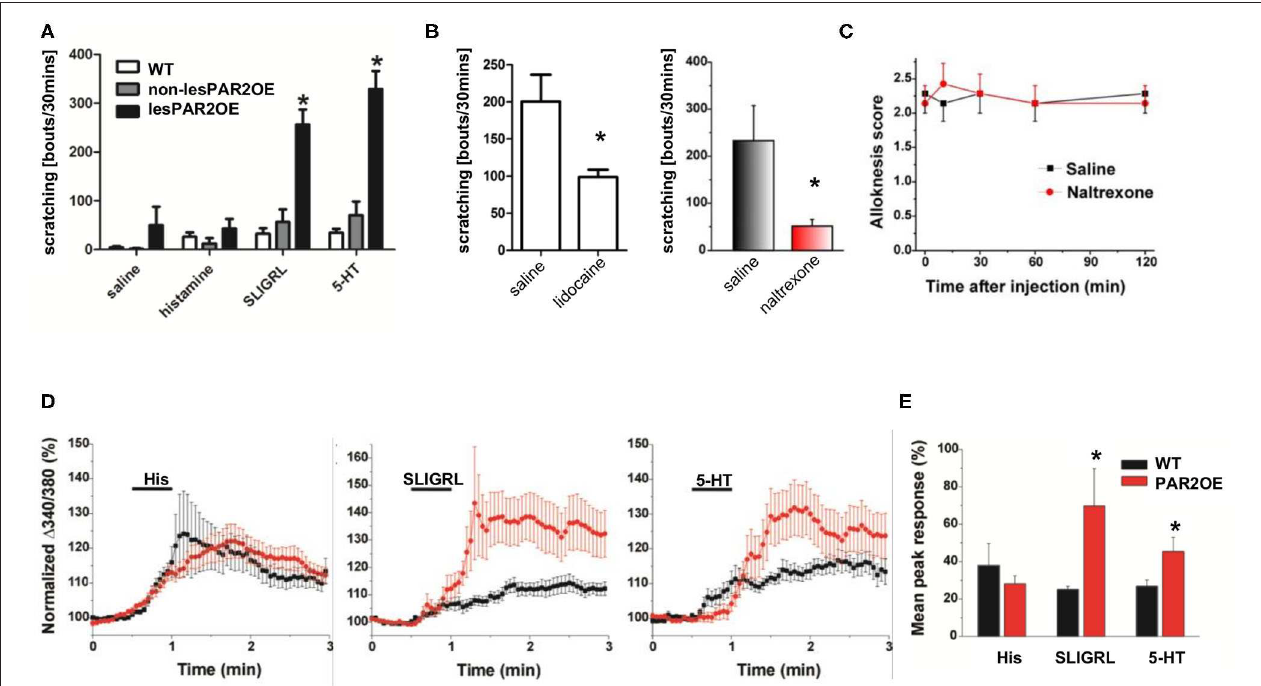
FIGURE 7 | Analysis of sensitization of itch signaling pathways in PAR2OE mice. (A) Injection of saline, histamine, SLIGRL, and 5-HT into lesional and non-lesional PAR2OE mice, as well as WT mice. Spontaneous scratching bouts have been substracted from the results ( n = 3–7 for each group). All graphs in this figure show mean ± SEM. *significantly different compared to WT mice or non-lesional PAR2OE mice ( p < 0.05, one-way ANOVA followed by the Bonferroni test). (B) Subcutaneous application of lidocaine (Lido) or naltrexone (Nal) to PAR2OE mice, each in comparison to saline (Sal) application. Determination of spontaneous scratching behavior during 30min video recording ( n = 8 mice per group). Spontaneous scratching was not substracted here as in panel (A) . * p < 0.05 (unpaired t -test). (C) Alloknesis score over 120min after injection of naltrexone vs. saline ( n = 7 mice per group). WT mice had alloknesis scores of 0 (data not shown). (D) Calcium responses of cultured DRG cells from PAR2OE and littermate WT mice after stimulation with histamine, SLIGRL, and 5-HT [same pruritogens as injected in vivo in panel (A) ]. (E) Summary of the results from panel (D) : mean 1 peak response is depicted here. * p < 0.05 (unpaired t